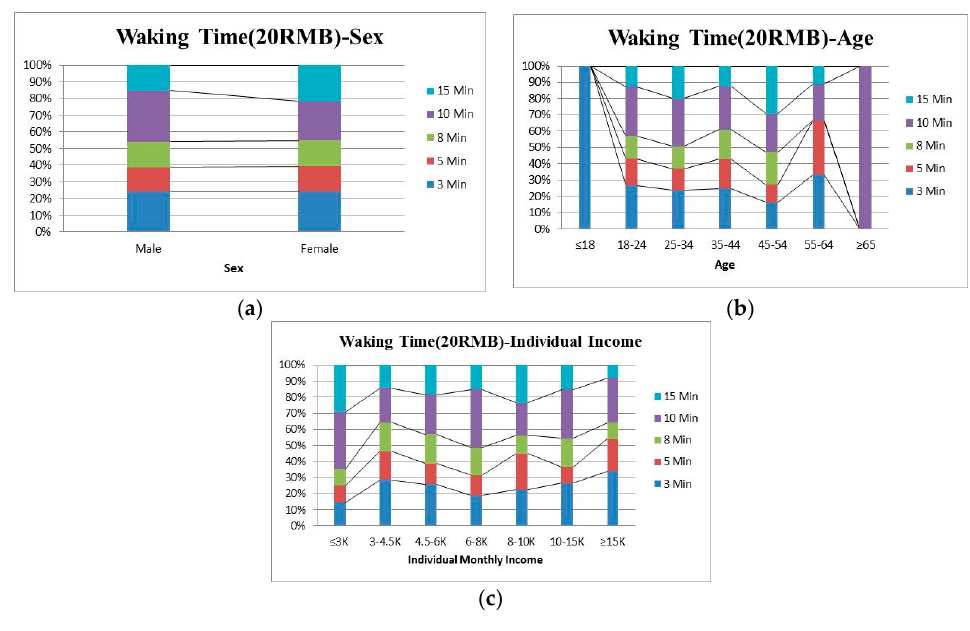
Figure A4. Relationship between walking time and significant variables (Saving 20 RMB): ( a ) Relationship between walking time and sex; ( b ) Relationship between walking time and age; ( c ) Relationship between walking time and individual income.